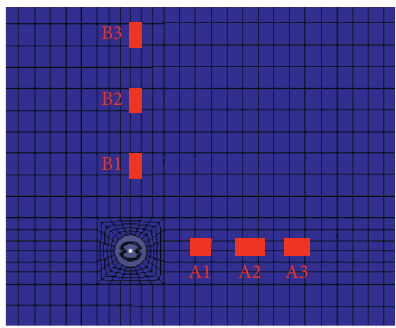
Figure 8: Selection locations of monitoring units and nodes.